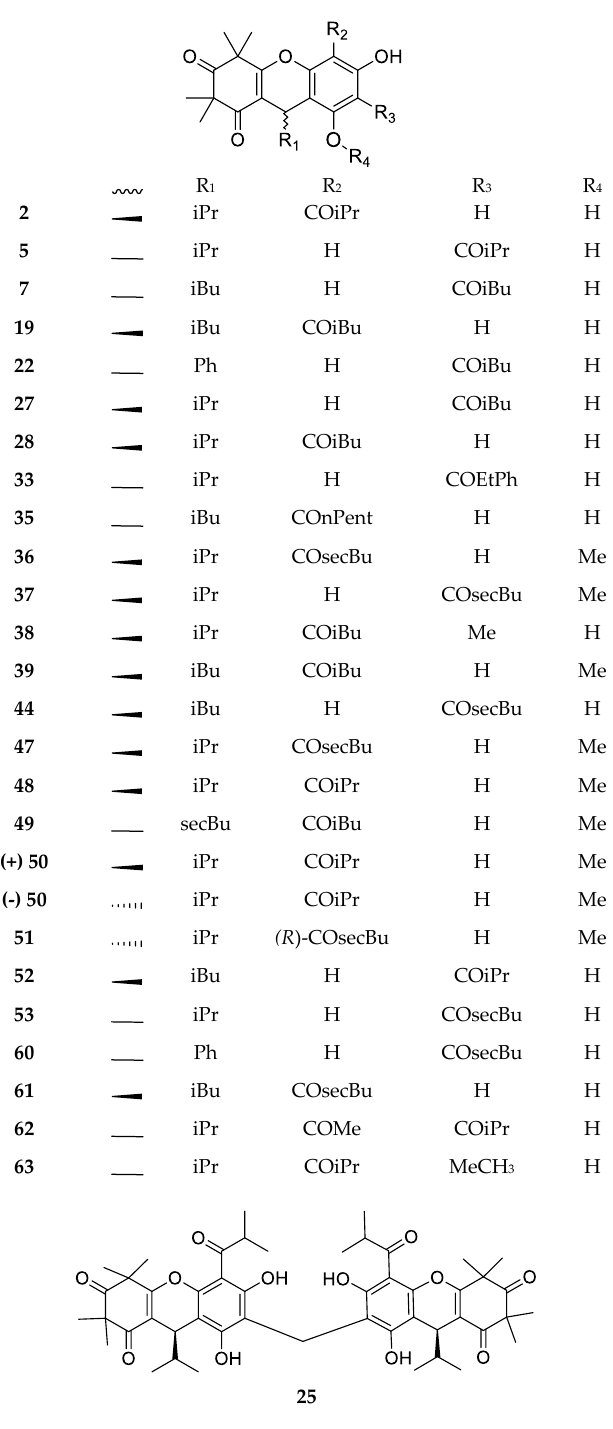
Figure 2. Structures of compounds of the dimeric-monopyrane type.